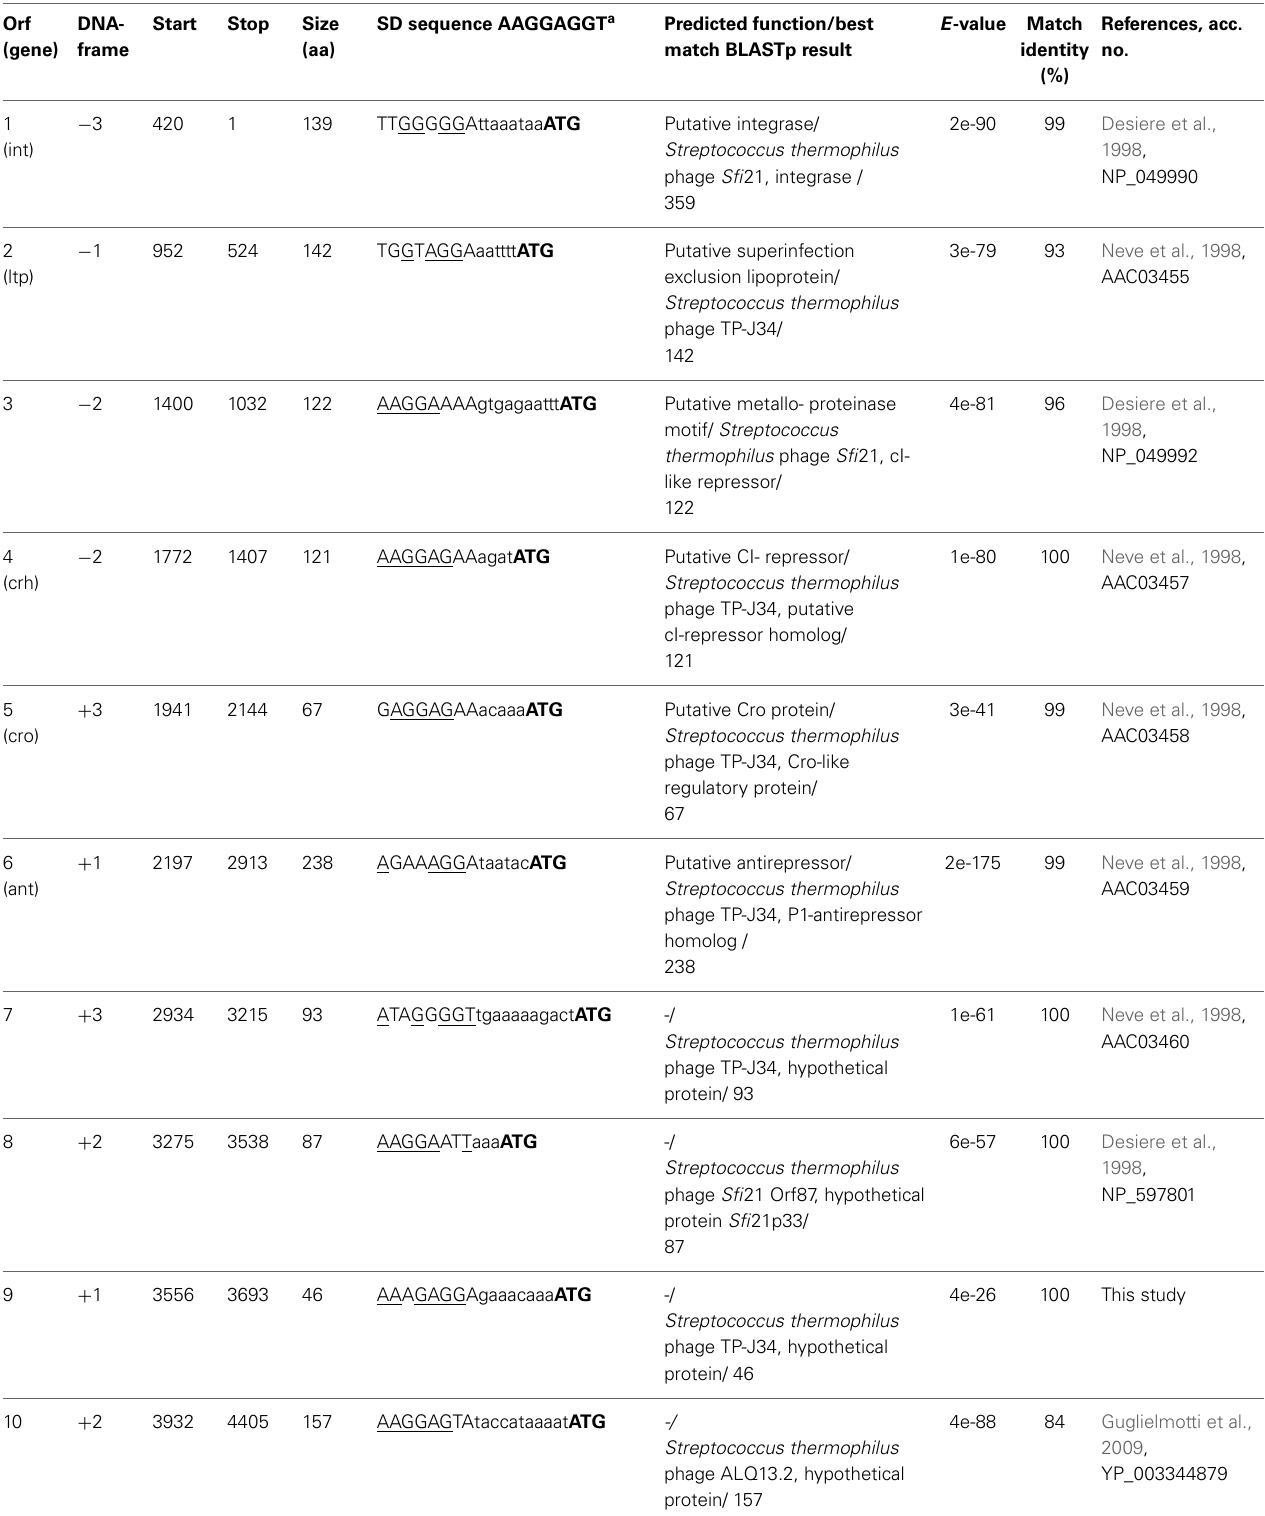
Table 4 | Features of phage TP-778L orf s and putative functions of their products.